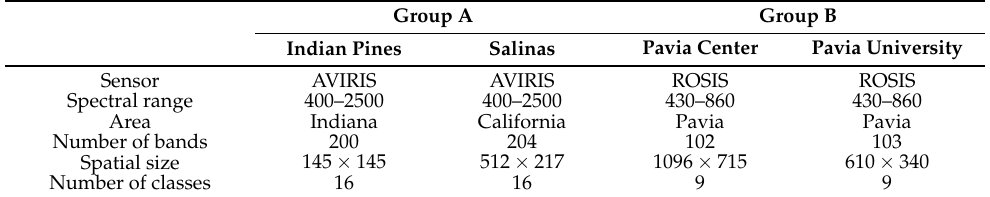
Table 1. Detailed information of four hyperspectral datasets. Indian Pines, Salinas, Pavia Center and Pavia